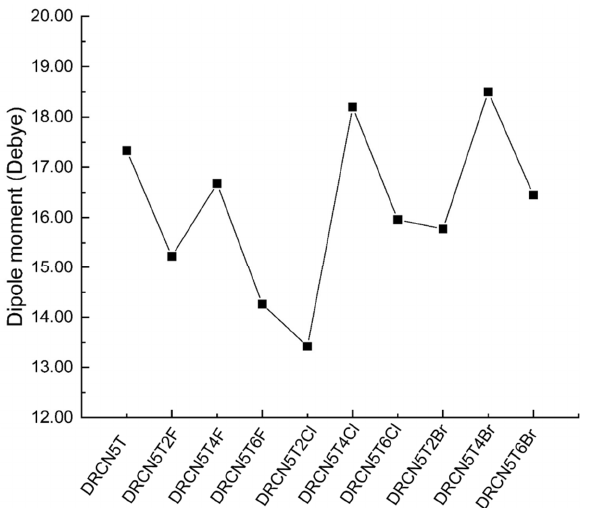
Figure 4. The calculated dipole moments of DRCN5T, DRCN5T2F, DRCN5T4F, DRCN5T6F, DRCN5T2Cl, DRCN5T4Cl, DRCN5T6Cl, DRCN5T2Br, DRCN5T4Br, and DRCN5T6Br gained with CAM-B3LYP/6 − 31+G(d) in film.